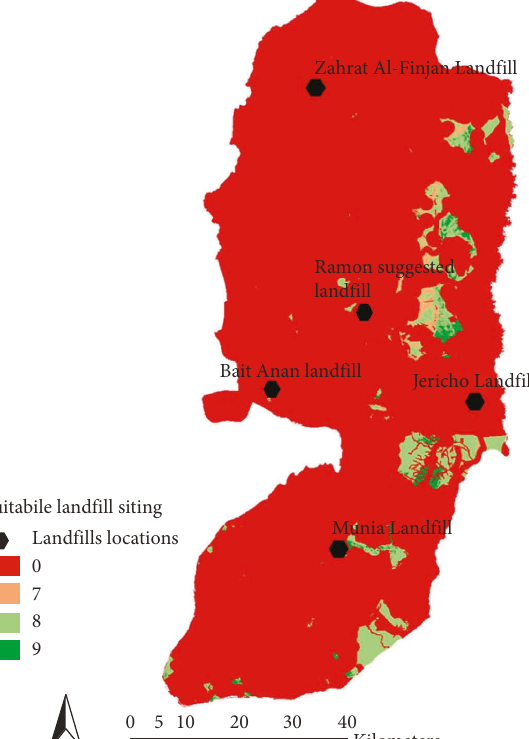
Figure 8: Existing regional landfill locations on the suitability landfill siting